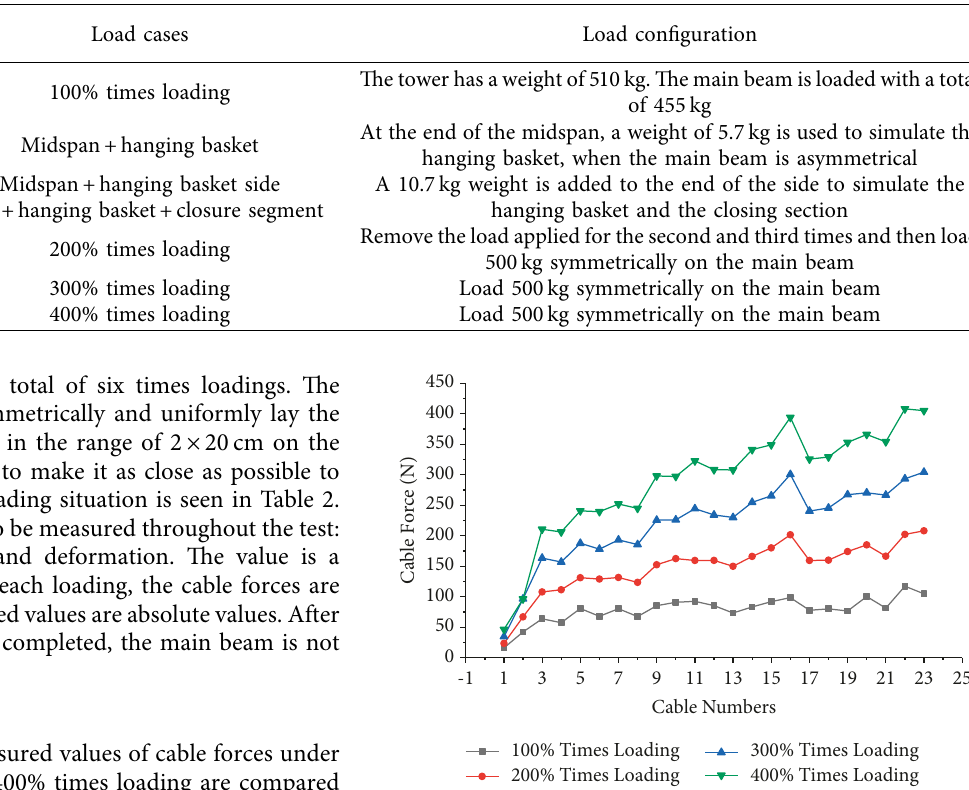
Table 2: Experimental conditions.